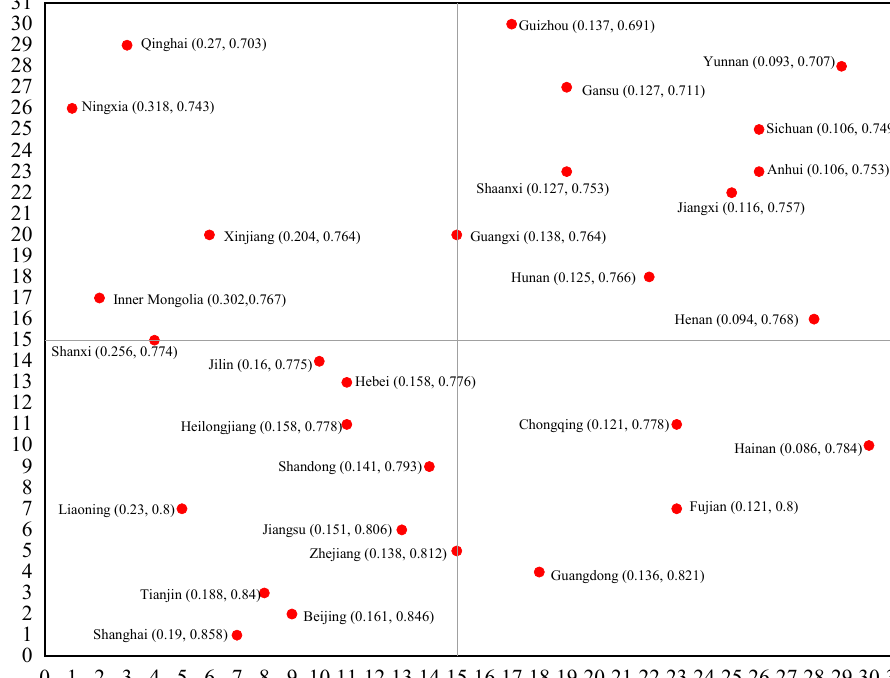
Figure 6. Quadrantal diagram of EWP effectiveness types of 30 provinces in China.